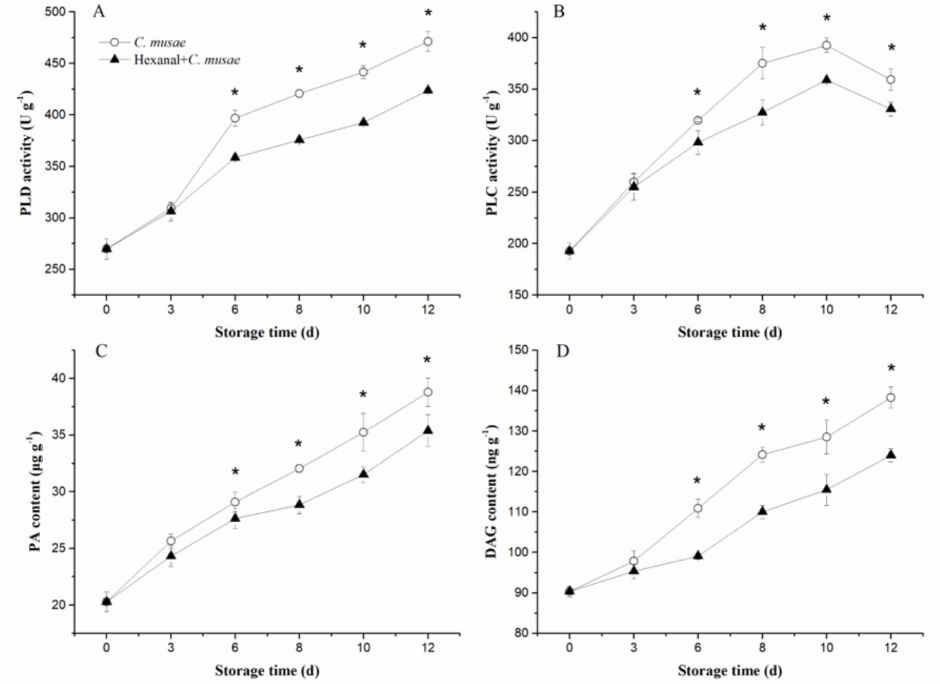
Figure 5. Effects of hexanal treatment on the activities of PLD ( A ) and PLC ( B ), the contents of PA ( C ) and DAG ( D ) in banana fruits inoculated with C. musae during storage for 12 days. The experiment was performed in triplicate. Asterisks indicated that values are significantly different between control and C. musae -treated fruits at the same time point using an LSD test (* p <